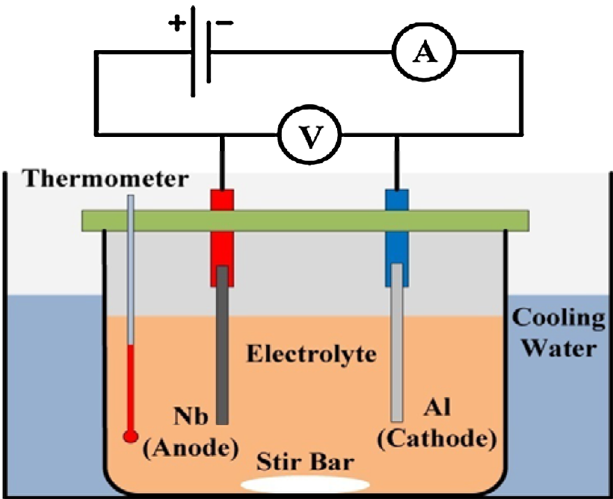
FIG. 1. (Color) Schematic installation of BEP for small